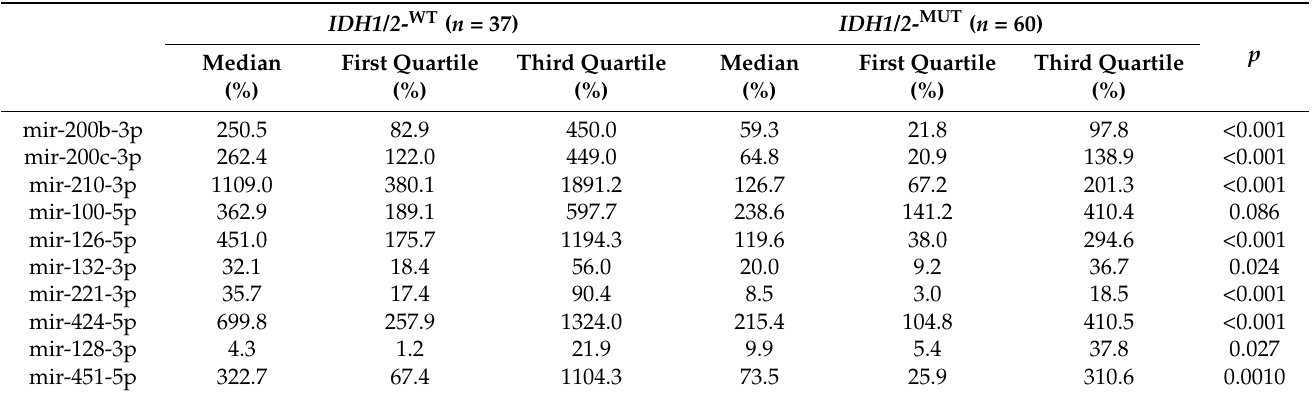
(Table 3), and (3) the histological subgroup (Table 4). Table 2. MiRNA expression according to the IDH1/2